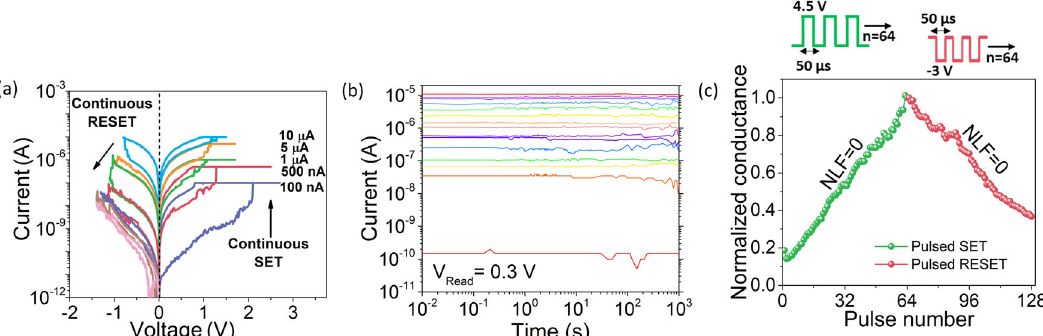
Fig. 3 Synaptic characteristics. a DC potentiation and depression. The graphene / MoS 2 /SiO x device exhibits 5 potentiation and 7 depression states. b Stable room temperature retention of 10 3 s for 15 distinct conductance states. c Linear and symmetric weight update observed in graphene / MoS 2 /SiO x device giving ideal asymmetry of ‘ 0 ’